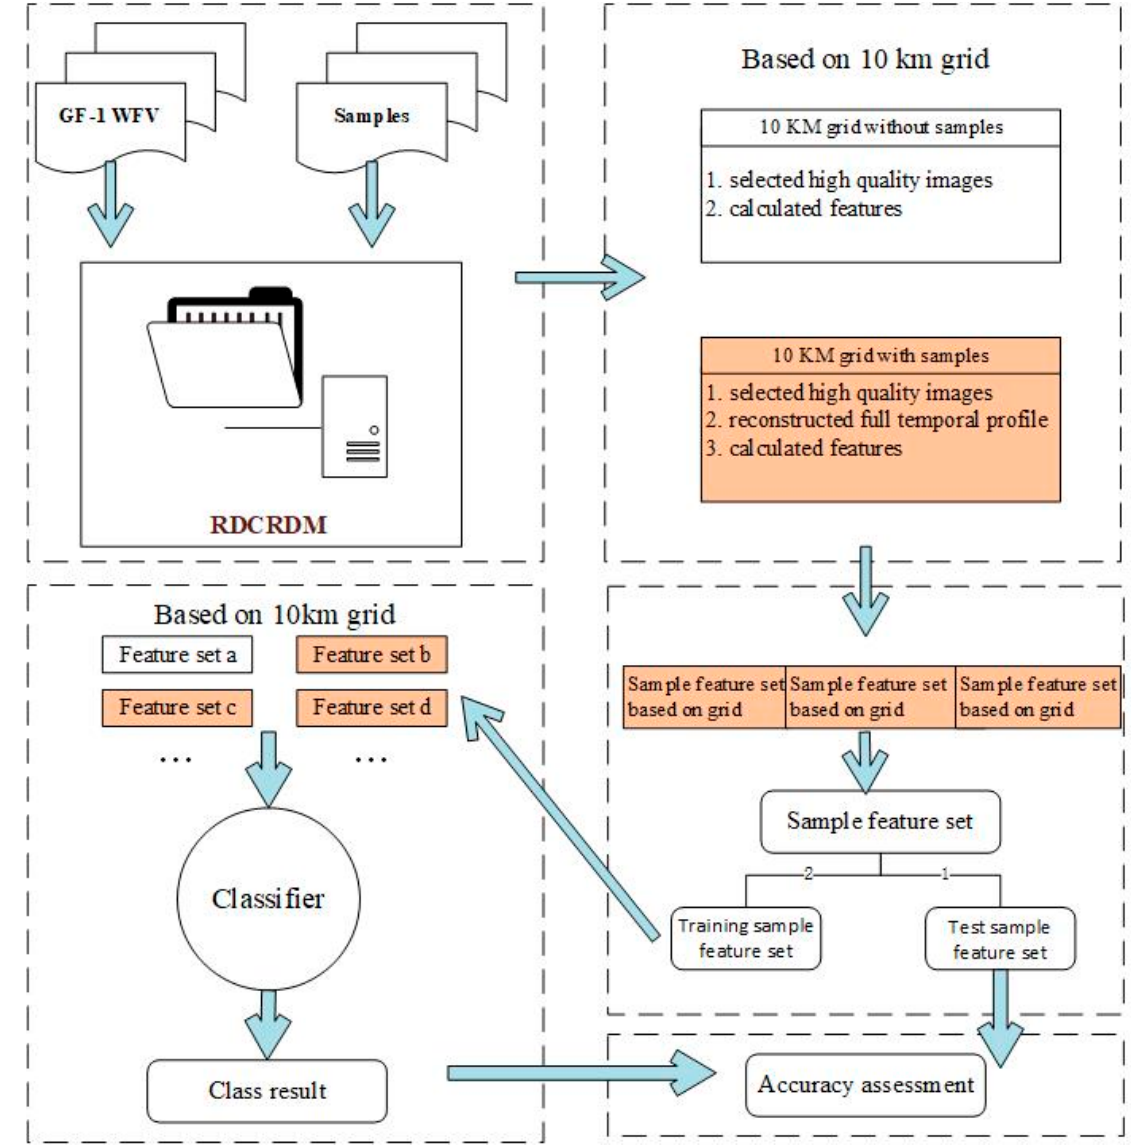
Figure 8. Workflow of our study, including five important steps: (1) data fed into the grid; (2) calculation of multitemporal features; (3) generation of training and test data; (4) classification. Steps 2 and 4 were based on a 10 km grid.